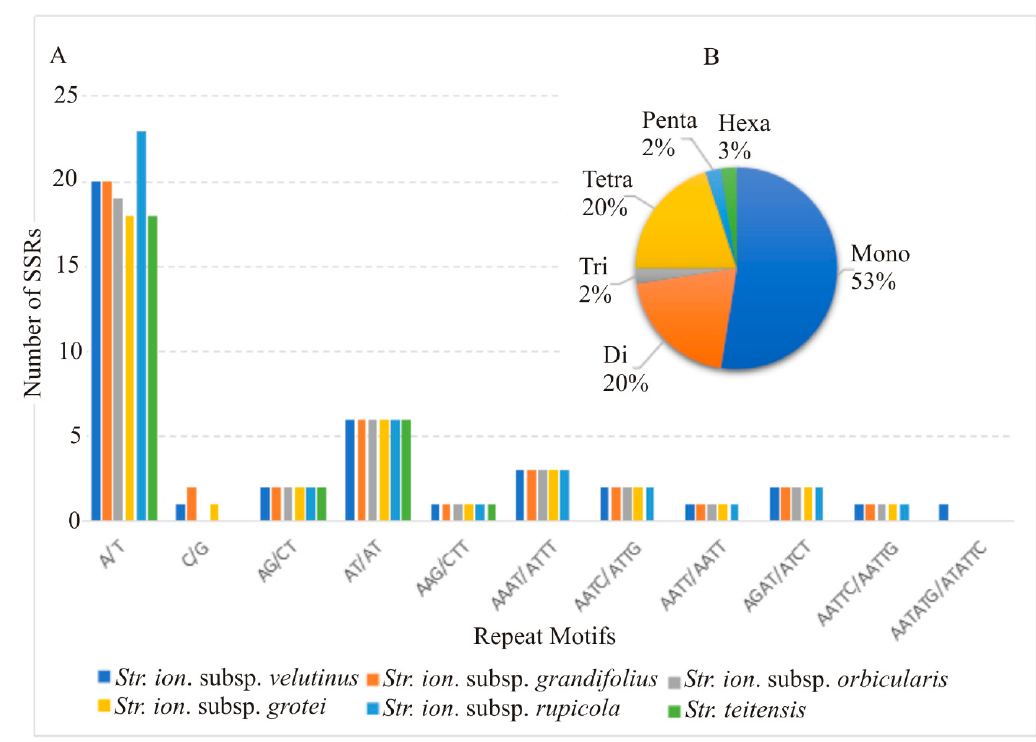
Figure 5. Simple Sequence Repeats (SSRs) in six sect. Saintpaulia chloroplast genomes. ( A ) Number of identified SSRs at different repeat motifs, ( B ) Percentage contribution of each repeat type.